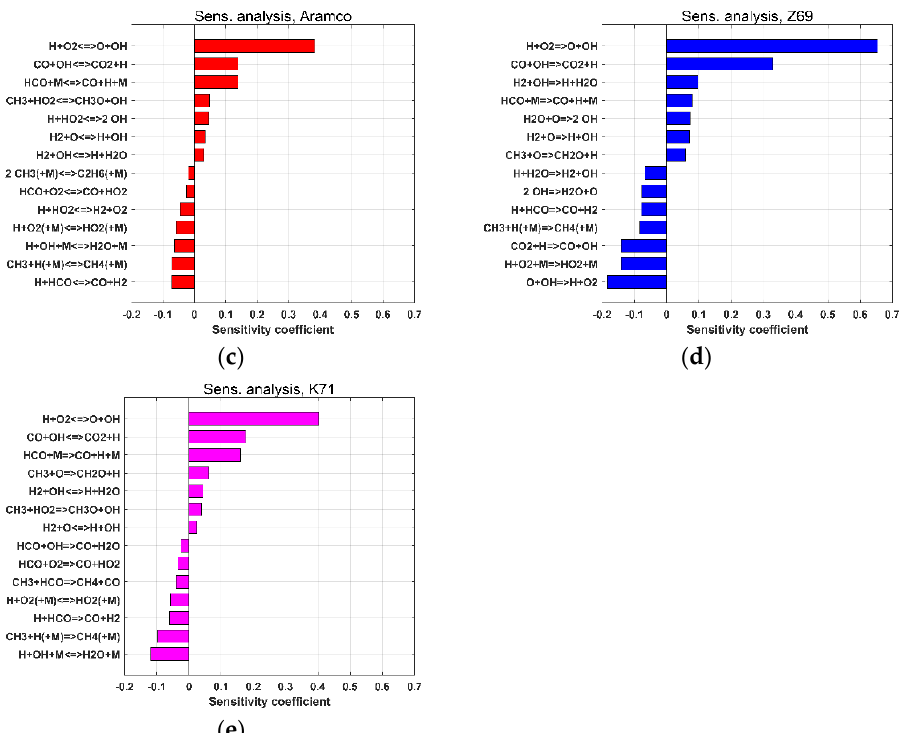
Figure 3. Sensitivity spectra of the fourteen most sensitive reactions for the San Diego mechanism in ( a ), the LLNL mechanism in ( b ), the Aramco mechanism in ( c ), Z69 in ( d ) and K71 in ( e ), all at ϕ = 1.0, 1 atm and 300 K.